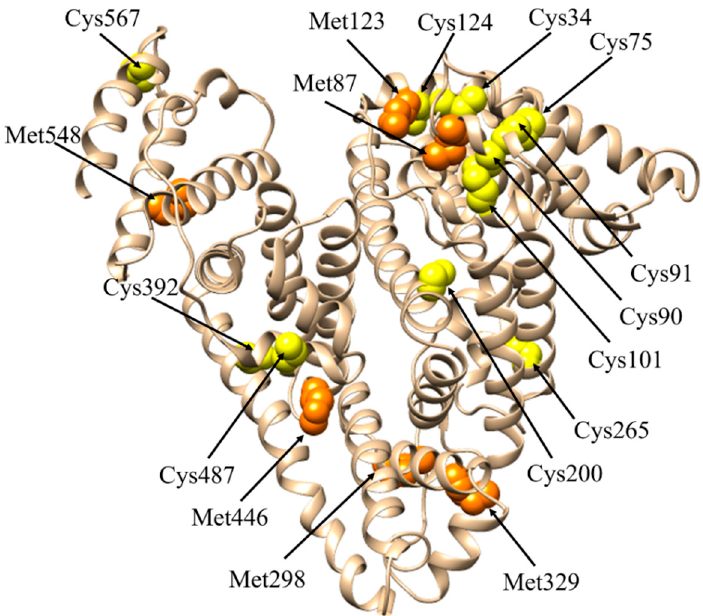
Figure 3. Met and Cys residues involved in HSA redox reactions. Met residues are shown as orange spheres, whereas Cys residues are depicted as yellow spheres. The picture has been drawn with UCSF-Chimera package [45].